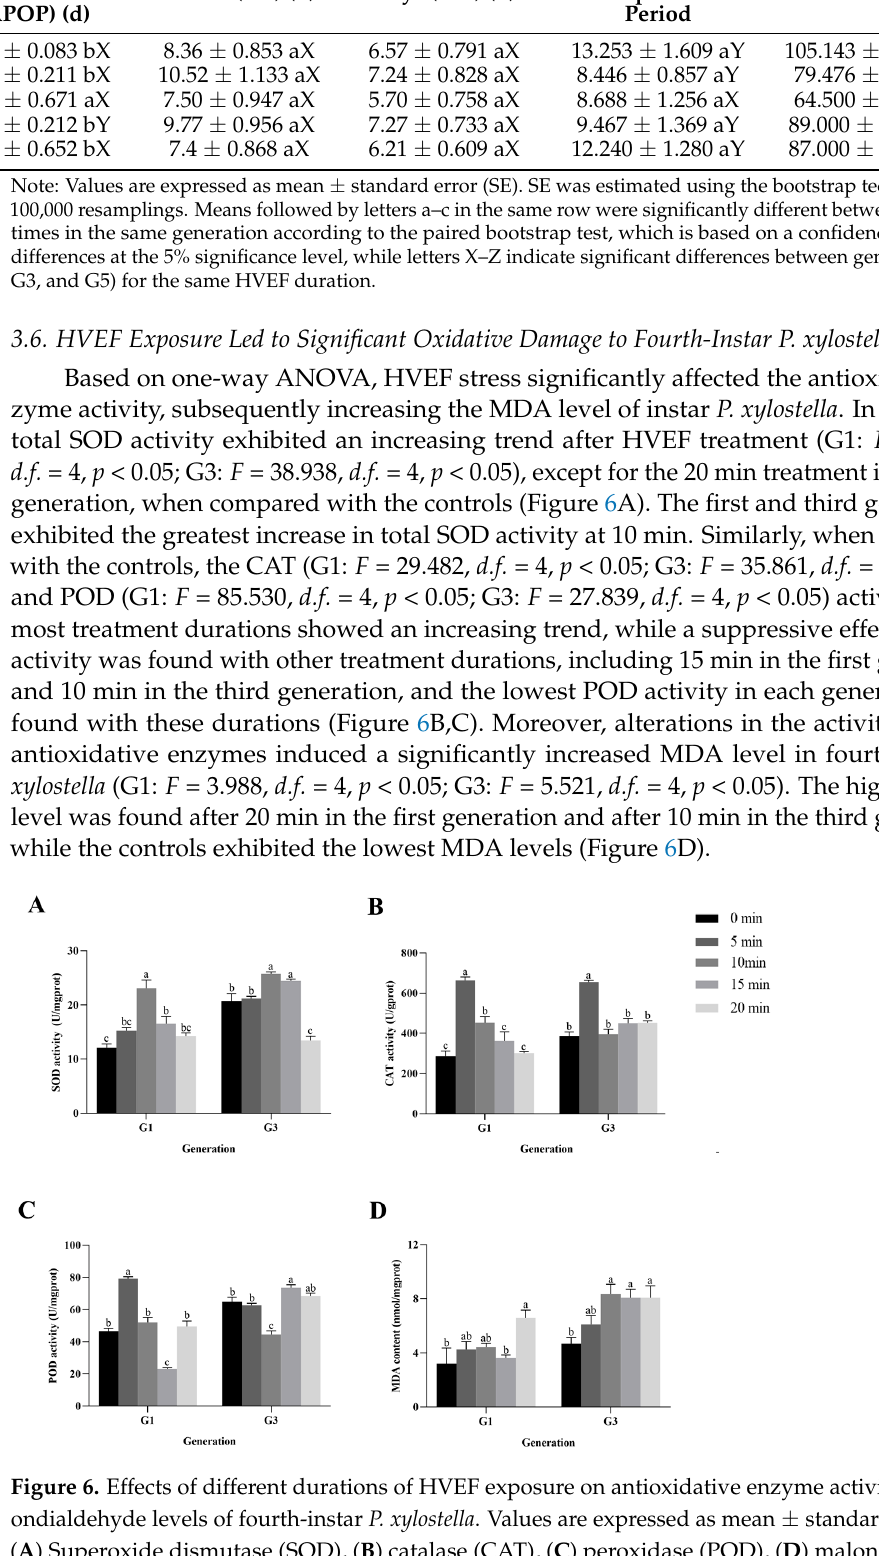
Figure 6. Effects of different durations of HVEF exposure on antioxidative enzyme activity and malondialdehyde levels of fourth-instar P. xylostella . Values are expressed as mean ± standard error (SE). ( A ) Superoxide dismutase (SOD), ( B ) catalase (CAT), ( C ) peroxidase (POD), ( D ) malondialde- hyde (MDA). Different lowercase letters indicate significant differences ( p < 0.05).